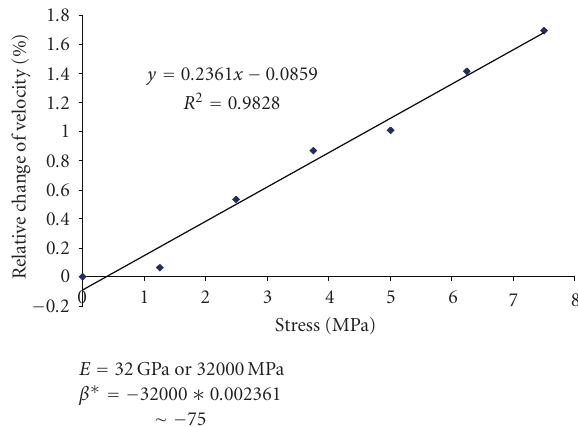
Figure 7: Calculation of non-linear parameter β ∗ for load cycle 2. The average values of velocity measurements over a low stress range of 0 to 7.5 MPa (23% of load at failure) were used in the calculations.